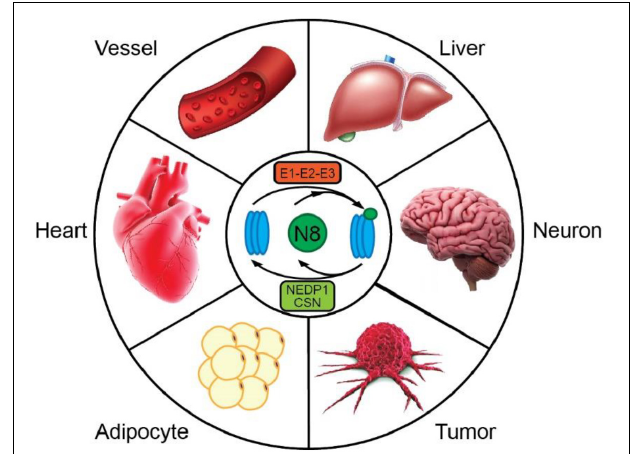
FIGURE 1 | Neddylation has emerged as a powerful mechanism for regulating cellular physiology in a variety of tissues. Dysregulation of neddylation has been linked to vascular diseases, such as neointima formation and atherosclerosis, liver steatosis, cognitive deficits, tumor growth, obesity, and heart failure. Modulation of this pathway may provide opportunities for combating diverse human